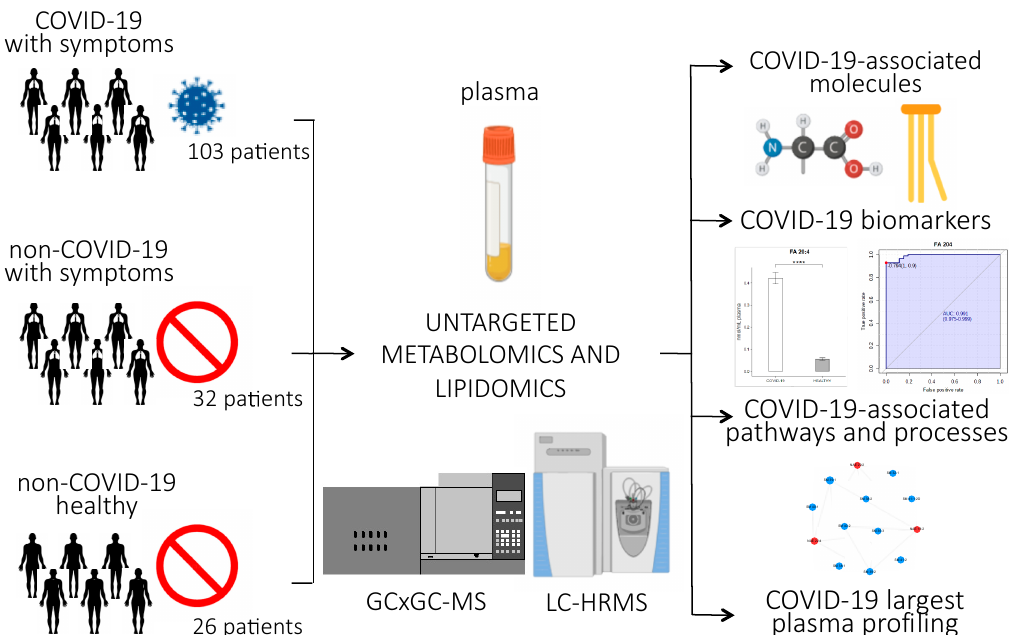
Figure 1. Experimental design of the study: Untargeted lipidomics and metabolomics analyses were performed on plasma samples from 103 patients infected with SARS-CoV-2, 84 of whom had non-critical COVID-19, while 19 had critical COVID-19 and recovered in the ICU; 20 non-COVID-19 patients with similar clinical symptoms as the COVID-19 patients; 26 healthy subjects; and 12 ICU patients who tested negative for COVID-19. The abundance of small molecules and lipids were used to identify COVID-19-associated biomarkers, pathways, and processes related to the host response to the virus. ( p -value < 0.0001 =